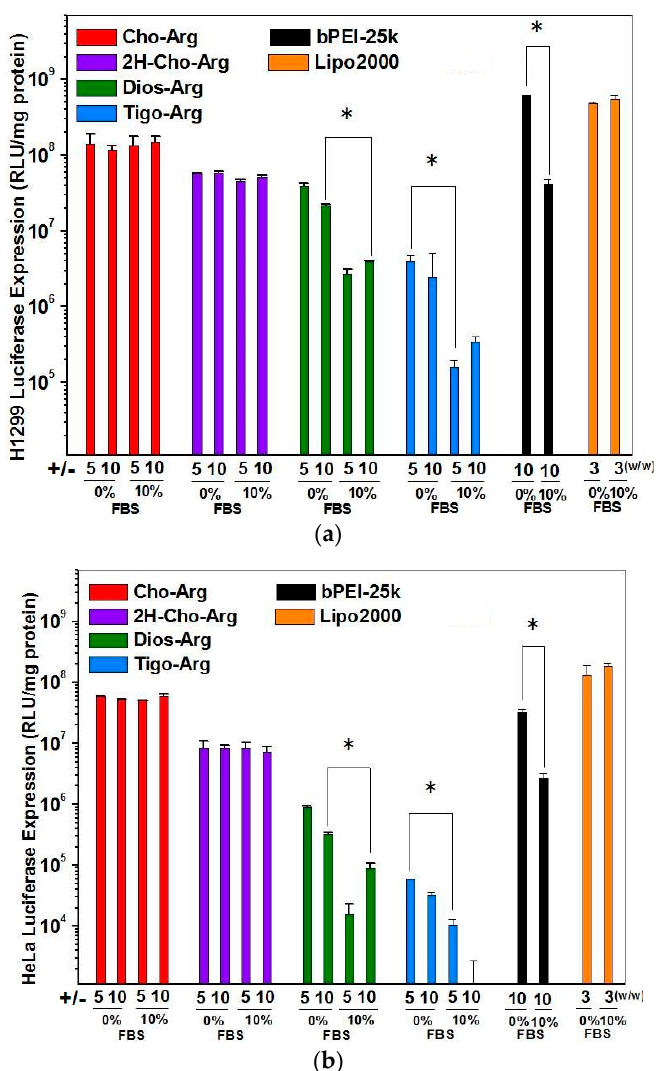
Figure 4. Luciferase gene transfection efficiency for the steroid-based cationic lipids/pDNA lipoplexes under various +/ − charge ratios in the absence/presence of serum in: ( a ) H1299; and ( b ) HeLa cell lines. bPEI-25K and Lipo2000 were used as controls.